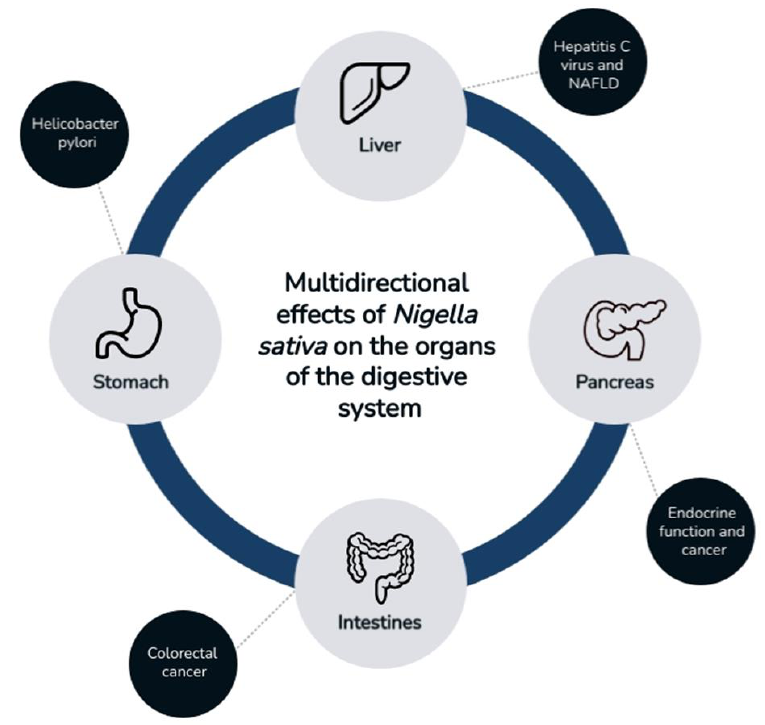
Figure 1. Effect of Nigella sativa on the digestive tract.